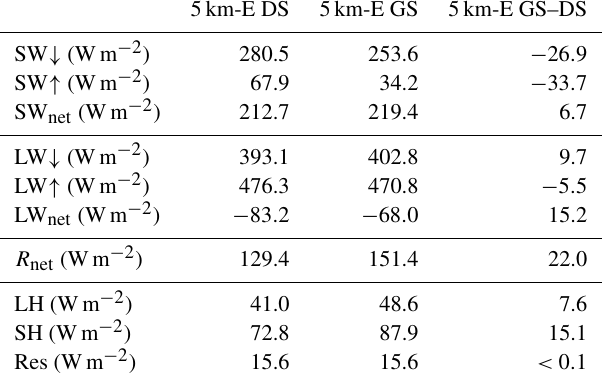
Table 1. JAS mean values of radiation components at the surface averaged over the WA domain (Fig. 1) for the 5km-E DS and GS simulations. The abbreviations used are as follows: SW ↓ – downward, shortwave radiation, SW ↑ – upward, shortwave radia- tion, SW net – net shortwave radiation, LW ↓ – downward, longwave radiation, LW ↑ – upward, longwave radiation, LW net – net long- wave radiation, R net – net radiation, LH – latent heat flux, SH – sensible heat flux, Res – residuum term. 5km-E DS 5km-E